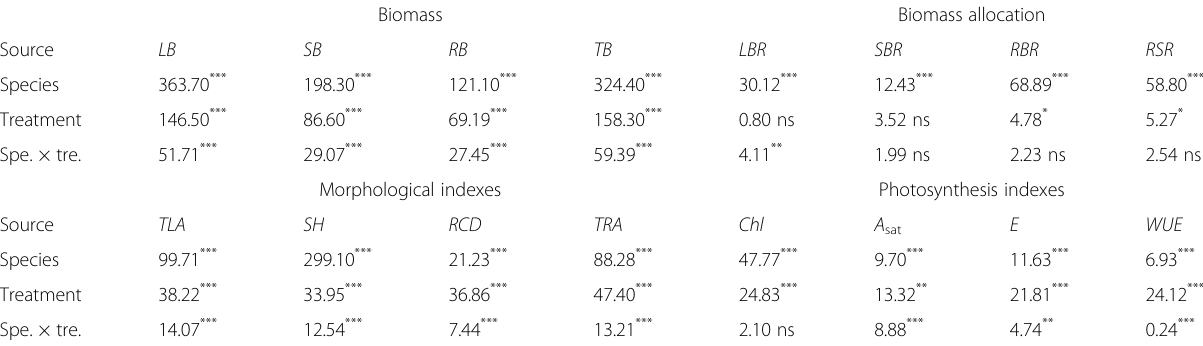
Table 2 F values of the effects of species, water treatment and interaction on seedling biomass, biomass allocation, morphological performance and photosynthesis capacity using a two-way ANOVA Biomass Biomass allocation